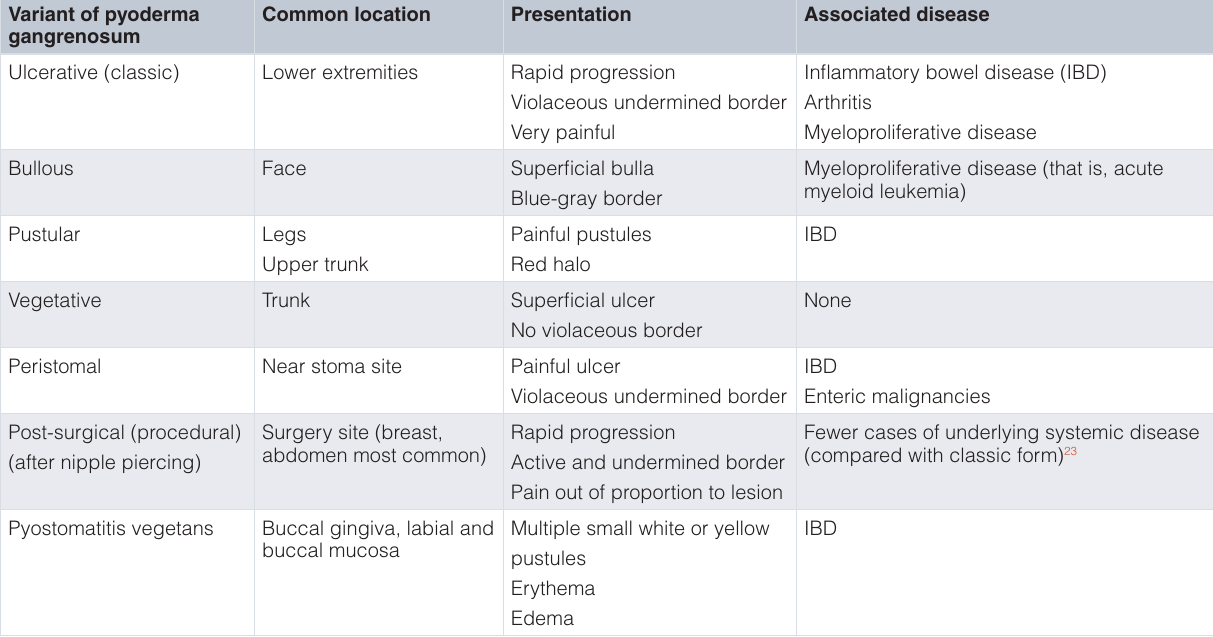
Table 2. Different clinical presentations of pyoderma gangrenosum and their associated systemic diseases 3,4,22,23 . Variant of pyoderma